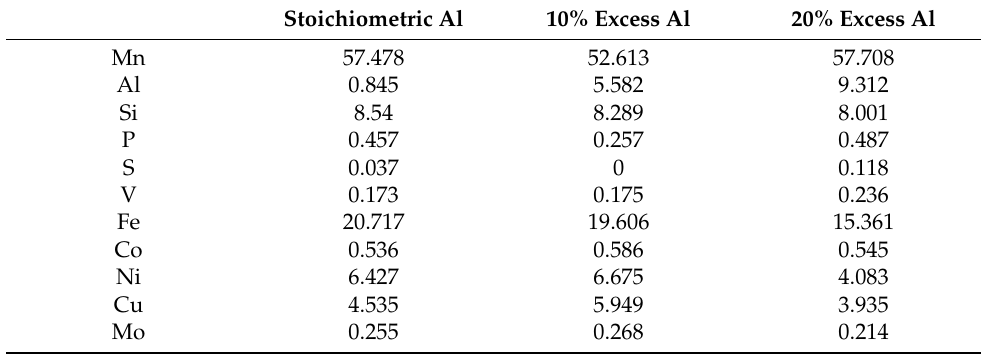
Table 2. Chemical composition of the alloys (in wt. %) prepared by reduction with a stoichiometric amount of aluminum, with 10% excess of aluminum and with 20% excess of